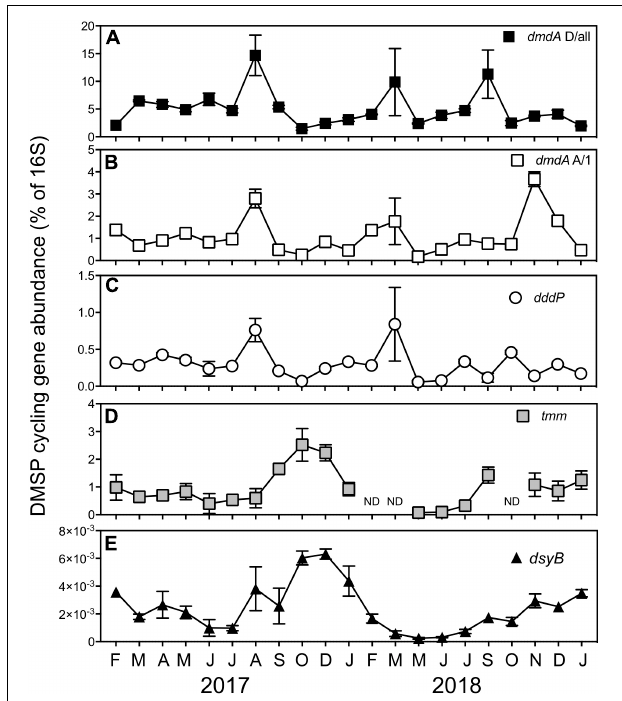
FIGURE 6 | A relative proportion of DMSP cycling genes encoding the DMSP demethylation genes, (A) dmdA subclade D/all and (B) dmdA subclade A/1, (C) the DMSP lyase gene, dddP , (D) the bacterial DMS oxidation gene, tmm , and (E) the bacterial production gene dsyB at Port Hacking between February 2017 and January 2019. All data are means ± standard error ( n = 3) and normalized to counts of the bacterial 16S rRNA gene. ND,